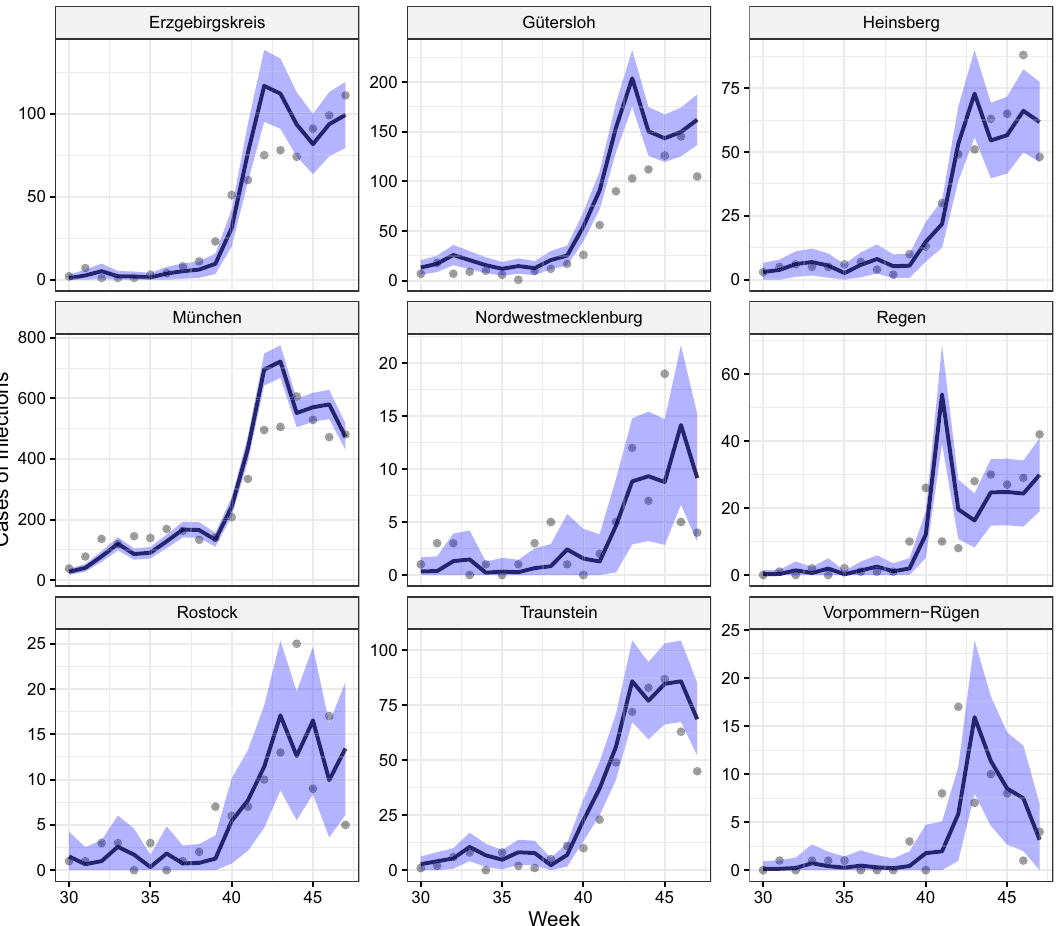
Figure 8. Prediction intervals for age group 15–34 and gender male and selected districts (facets) in Germany. For the different forecast weeks (x-axis) the true number of infections are visualized by points and contrasted with the model’s prediction (black line) and the prediction interval (shaded purple